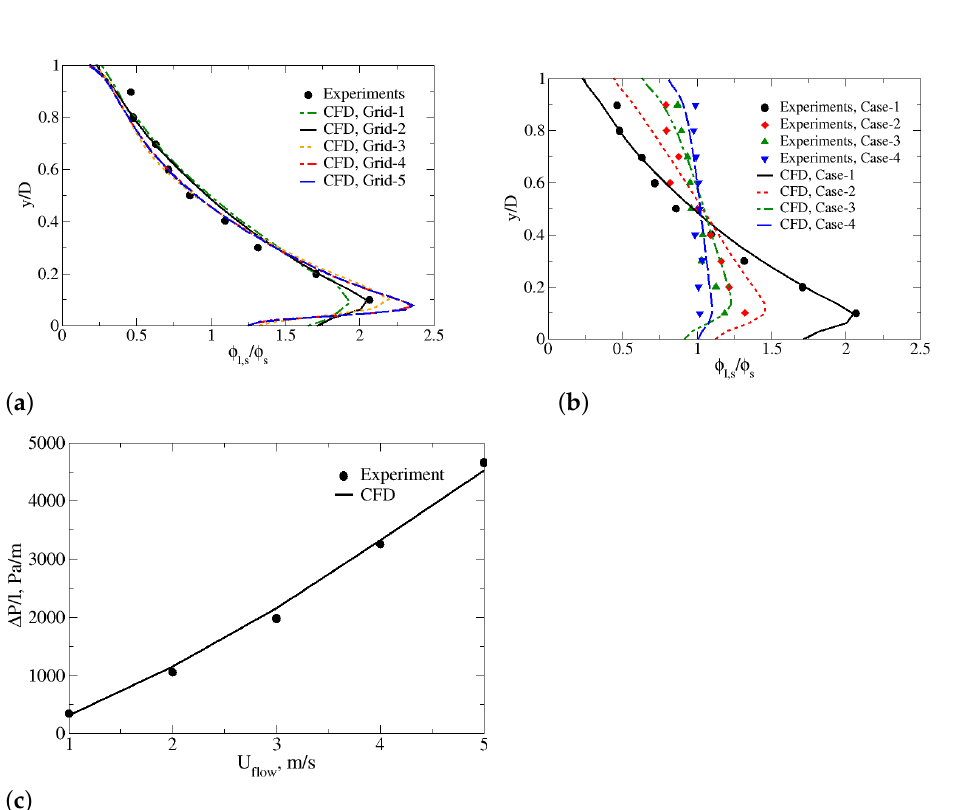
Figure 3. Validation: ( a ) Experimental and simulated solid concentration distribution in multi-sized slurry at U in = 2 m/s, φ s = 0.2. Grid-1: 237,500 cells; Grid-2: 456,000 cells; Grid-3: 863,500 cells, Grid-4: 1,484,000 cells; Grid-5: 3,648,000; ( b ) Experimental and simulated solid concentration distribution in multi-sized slurry with Grid-2. Case-1: U in = 2 m/s, φ s = 0.2; Case-2: U in = 3 m/s, φ s = 0.3; Case-3: U in = 4 m/s, φ s = 0.4; Case-4: U in = 5 m/s, φ s = 0.5; ( c ) Experimental and simulated pressure drop in Pa/m for multi-sized slurry at φ s =